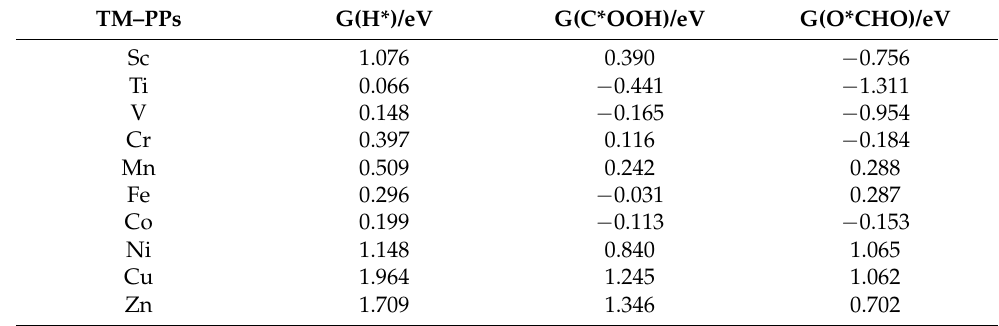
Table 4. The G(H*), G(C*OOH), and G(O*CHO) values of the intermediates used as the training sets for a series of transition-metal–porphyrin complexes (TM–PPs, TM = Sc, Ti, V, Cr, Mn, Fe, Co, Ni, Cu, and Zn). Reprinted from the supporting information of Ref.